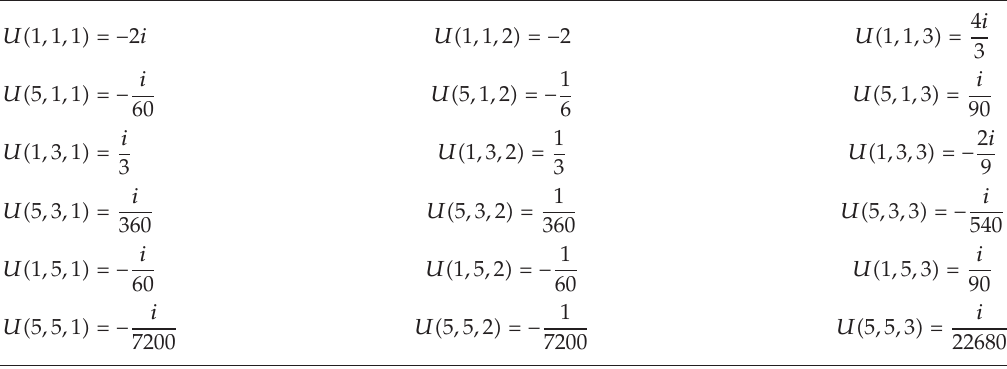
Table 5: Some values of U (cid:3) k,h,m (cid:4) in Example 4.4.